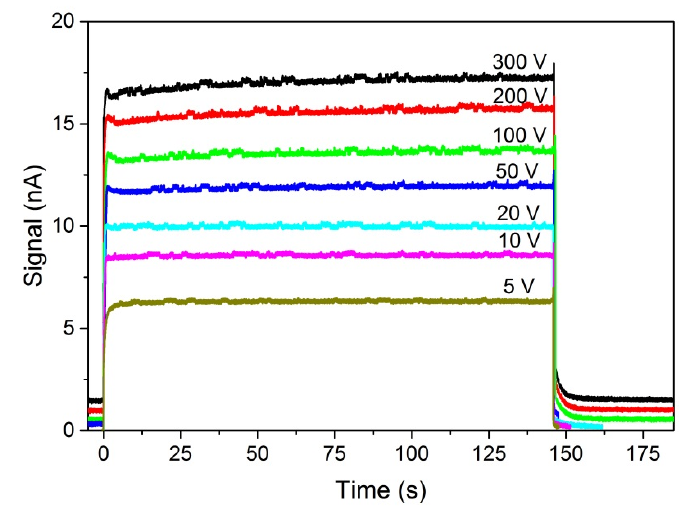
Figure 13. PC kinetics for the sample shown in Figure 12, F = 3.83 × 10 12 cm − 2 s − 1 , ħω = 1.531 eV ( E g − 44 meV). Charge carriers are generated inside the sample, not only at the surface. The shape of the PC time dependence does not depend on the bias voltage; only the amplitude depends on the bias voltage. The slight rise of the PC signal with time at V ≥ 100 V was attributed to the influence of holes.